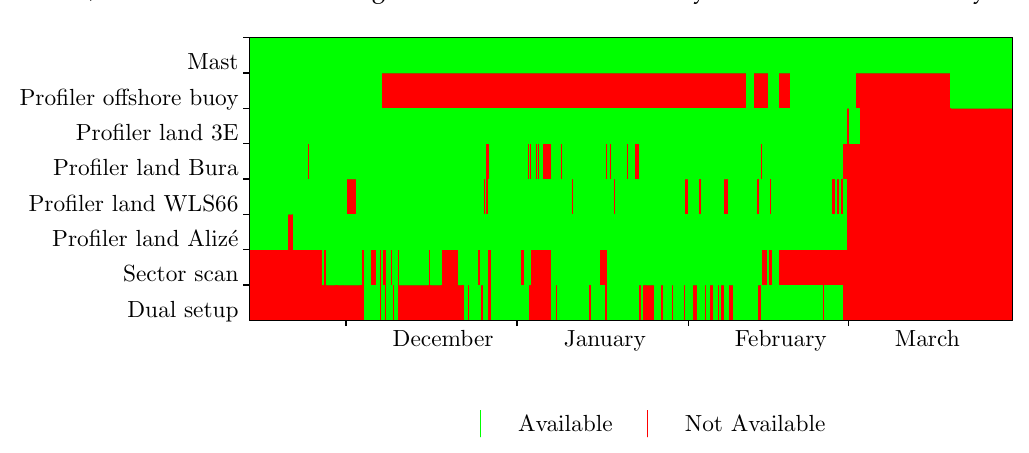
Figure 6. Actual availability of all reconstructed wind speeds in 10 min intervals that fulfilled the filtering